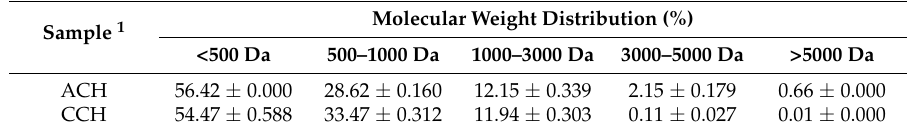
Table 1. Molecular weight distribution of collagen hydrolysates.